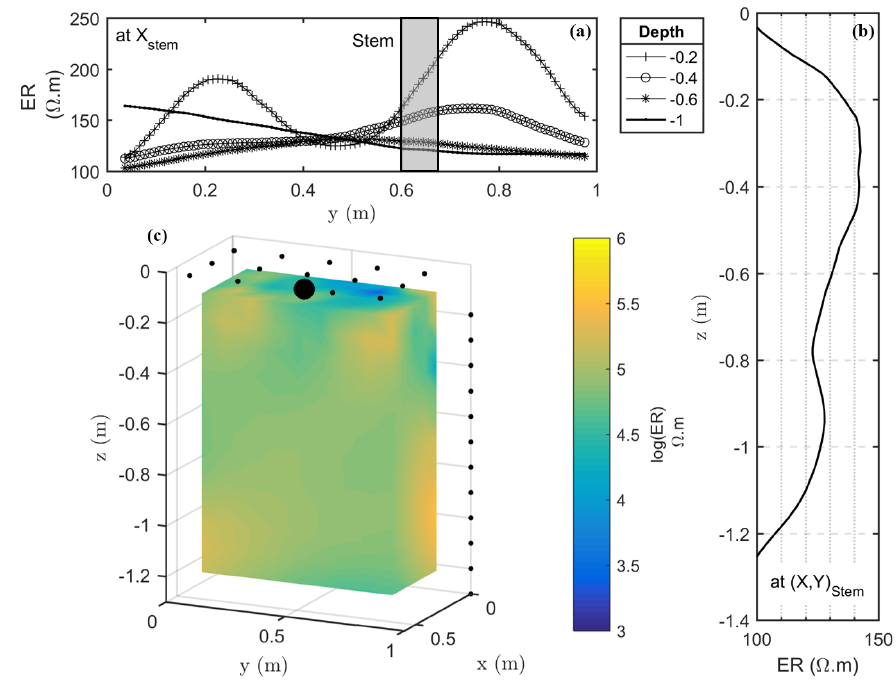
Figure 6. Results of the 3-D ERT inversion: (a) 2-D lateral ( y direction) variations of resistivity at four depths (0.2, 0.4, 0.6, 1m); (b) 2-D vertical variations of resistivity at the tree stem location; (c) 3-D resistivity volume (log scale) sliced at x = 0 . 5m, with the black point showing the location of the plant